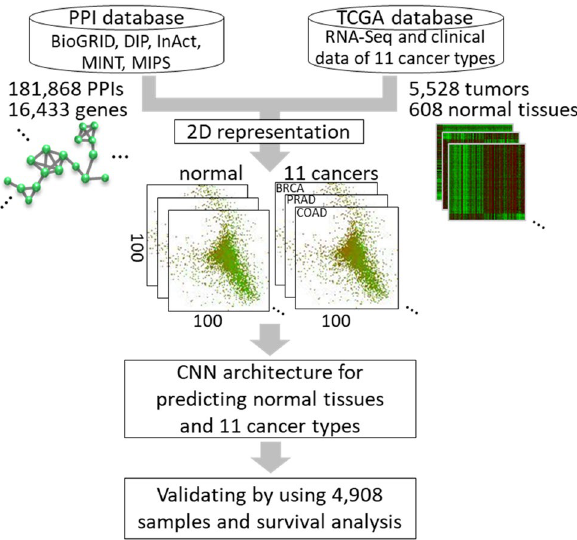
Figure 1. Schematic of integrating protein interaction networks and genomic profiling into convolutional neural network for multi-cancer classification. RNA-Seq data and clinical data of 6136 samples with 11 cancer types are collected from The Cancer Genome Atlas (TCGA) database, and 181,868 protein–protein interactions (PPIs) of 16,433 human proteins from five public databases. Then, Laplacian approach was utilized to map PPI network into 2D space and combined with the gene expression, to generate 608 normal and 5528 tumor sample images for convolutional neural network (CNN) model and validation